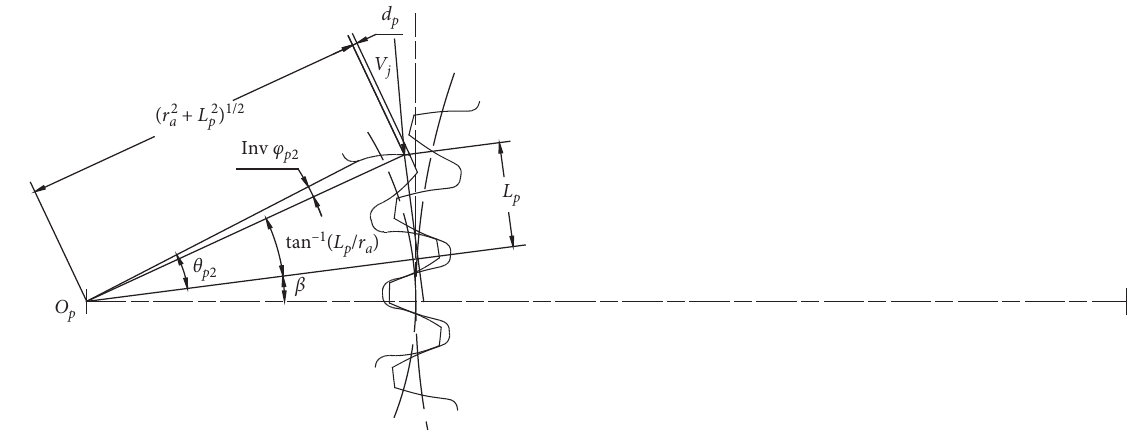
Figure 3: Diagram of impingement depth on the pinion ( t